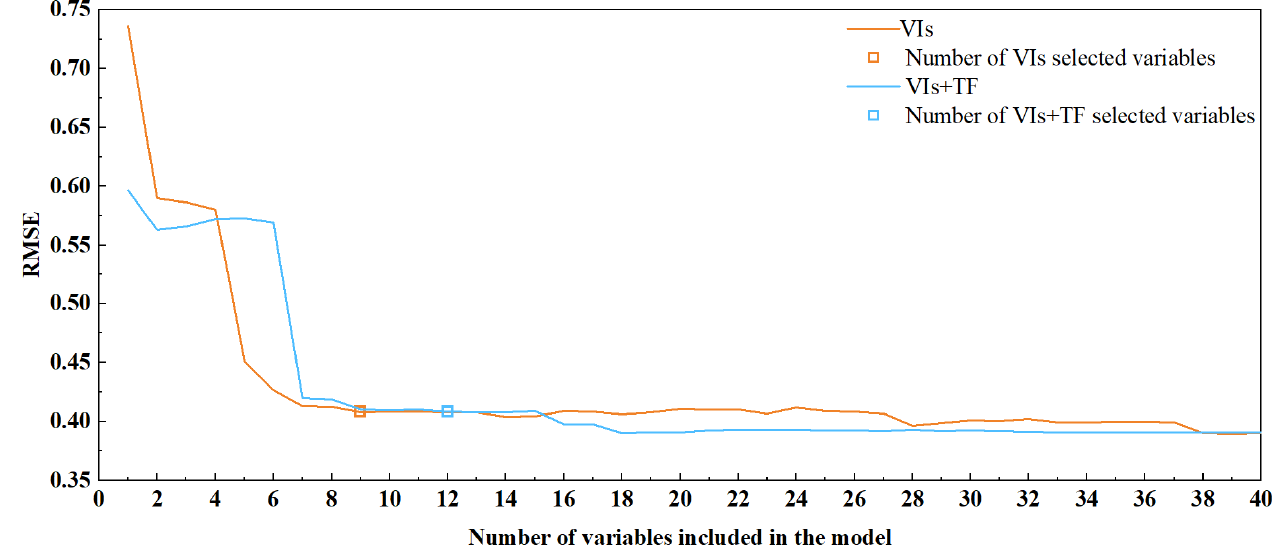
Figure 5. RMSE plot of the number of variables selected by SPA.